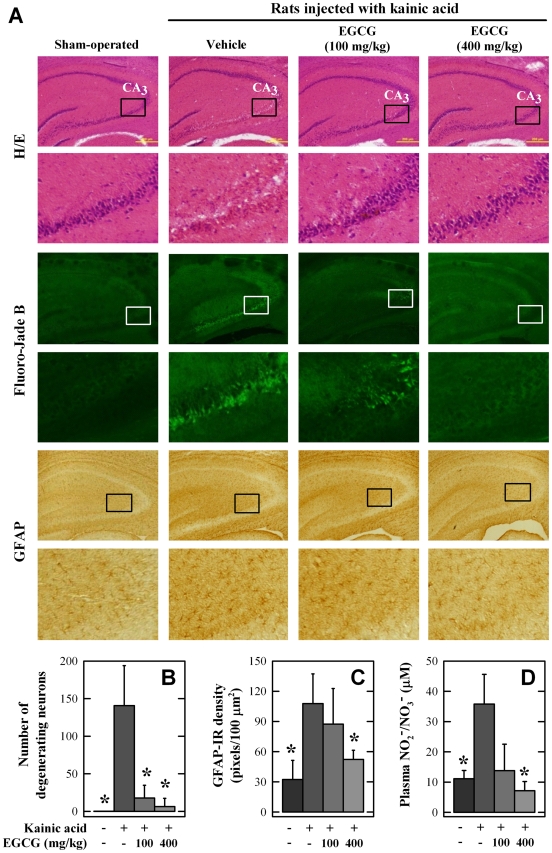
Effect of orally-administered EGCG on kainic acid-induced rat hippocampal injury.
A. Histopathological and histochemical analyses of the brain tissues. B. Number of degenerating neurons based on the Fluoro-Jade B staining. C. Expression levels of GFAP-immunoreactive (IR) astrocytes in the CA3 region. D. Plasma NO2
−/NO3
− levels. Rats (N = 3 for each group) were orally administered 100 or 400 mg/kg of EGCG 30 min before kainic acid injection. Kainic acid (1 µL of 1 mg/mL solution) was injected into the right lateral ventricle (anterior/posterior, −1.0; rostral, 1.6; dorsal/ventral, 4.5) using a microliter syringe. * P<0.05 compared to kainic acid-treated group.